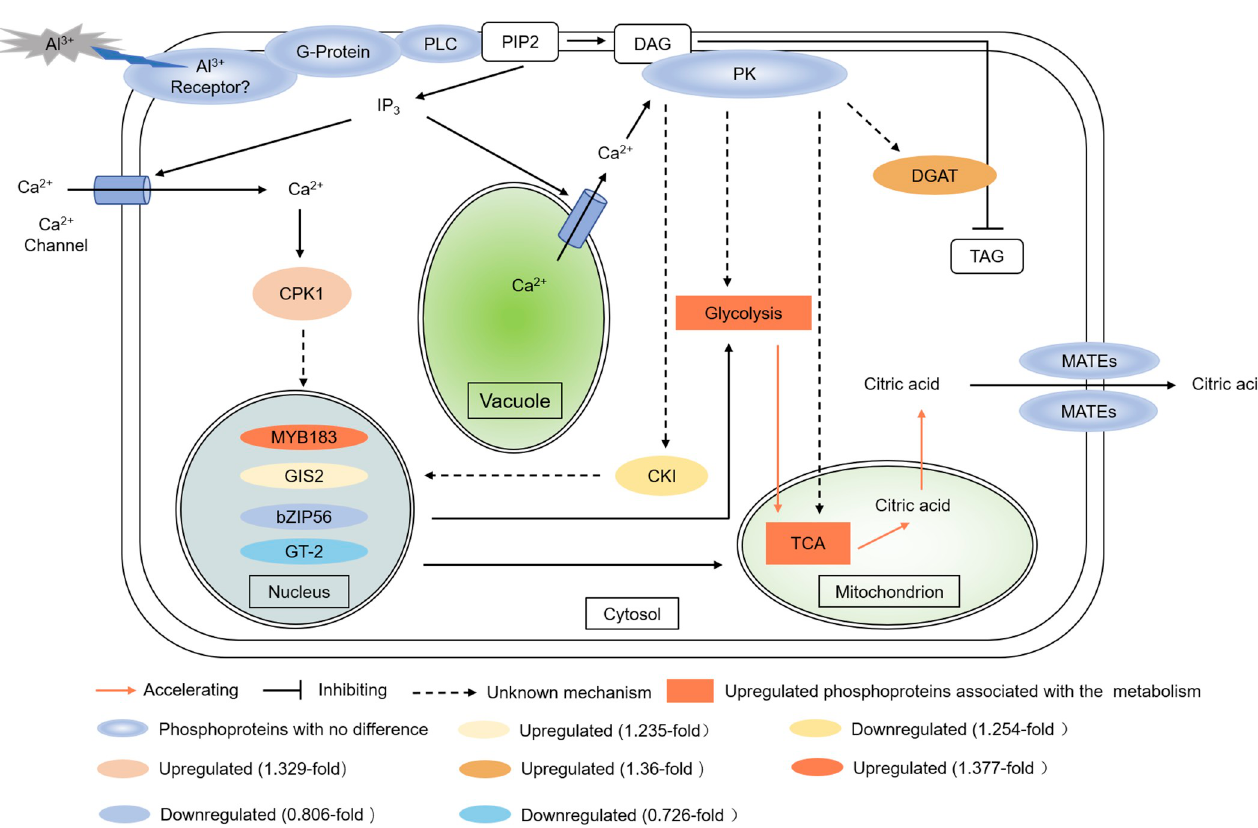
Fig 5. Putative model illustrating the signaling cascades of the Al 3+ -induced exudation of citrate from TBS roots. Phosphoinositide phospholipase C (PLC), phosphatidylinositol 4, 5-phosphate (PIP2), diacylglycerol (DAG), diacylglycerol acyltransferases (DGAT), triacylglycerol (TAG), protein kinases (PK), inositol triphosphate (IP3), calcium-dependent protein kinase (CPK), transcription factor (TF), casein kinase I (CKI), tricarboxylic acid (TCA).